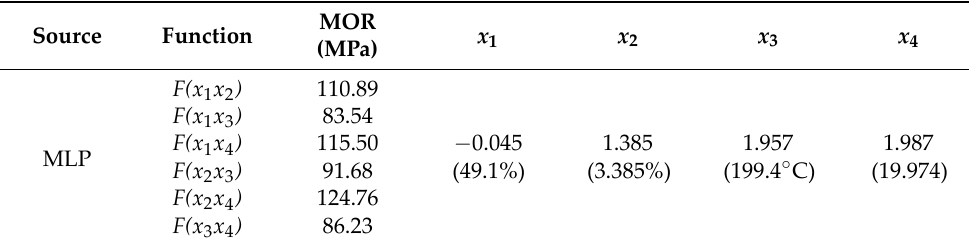
Table 6. Optimized value of the response (MOR) corresponding to each interactive effect of the variables obtained by the MLP.